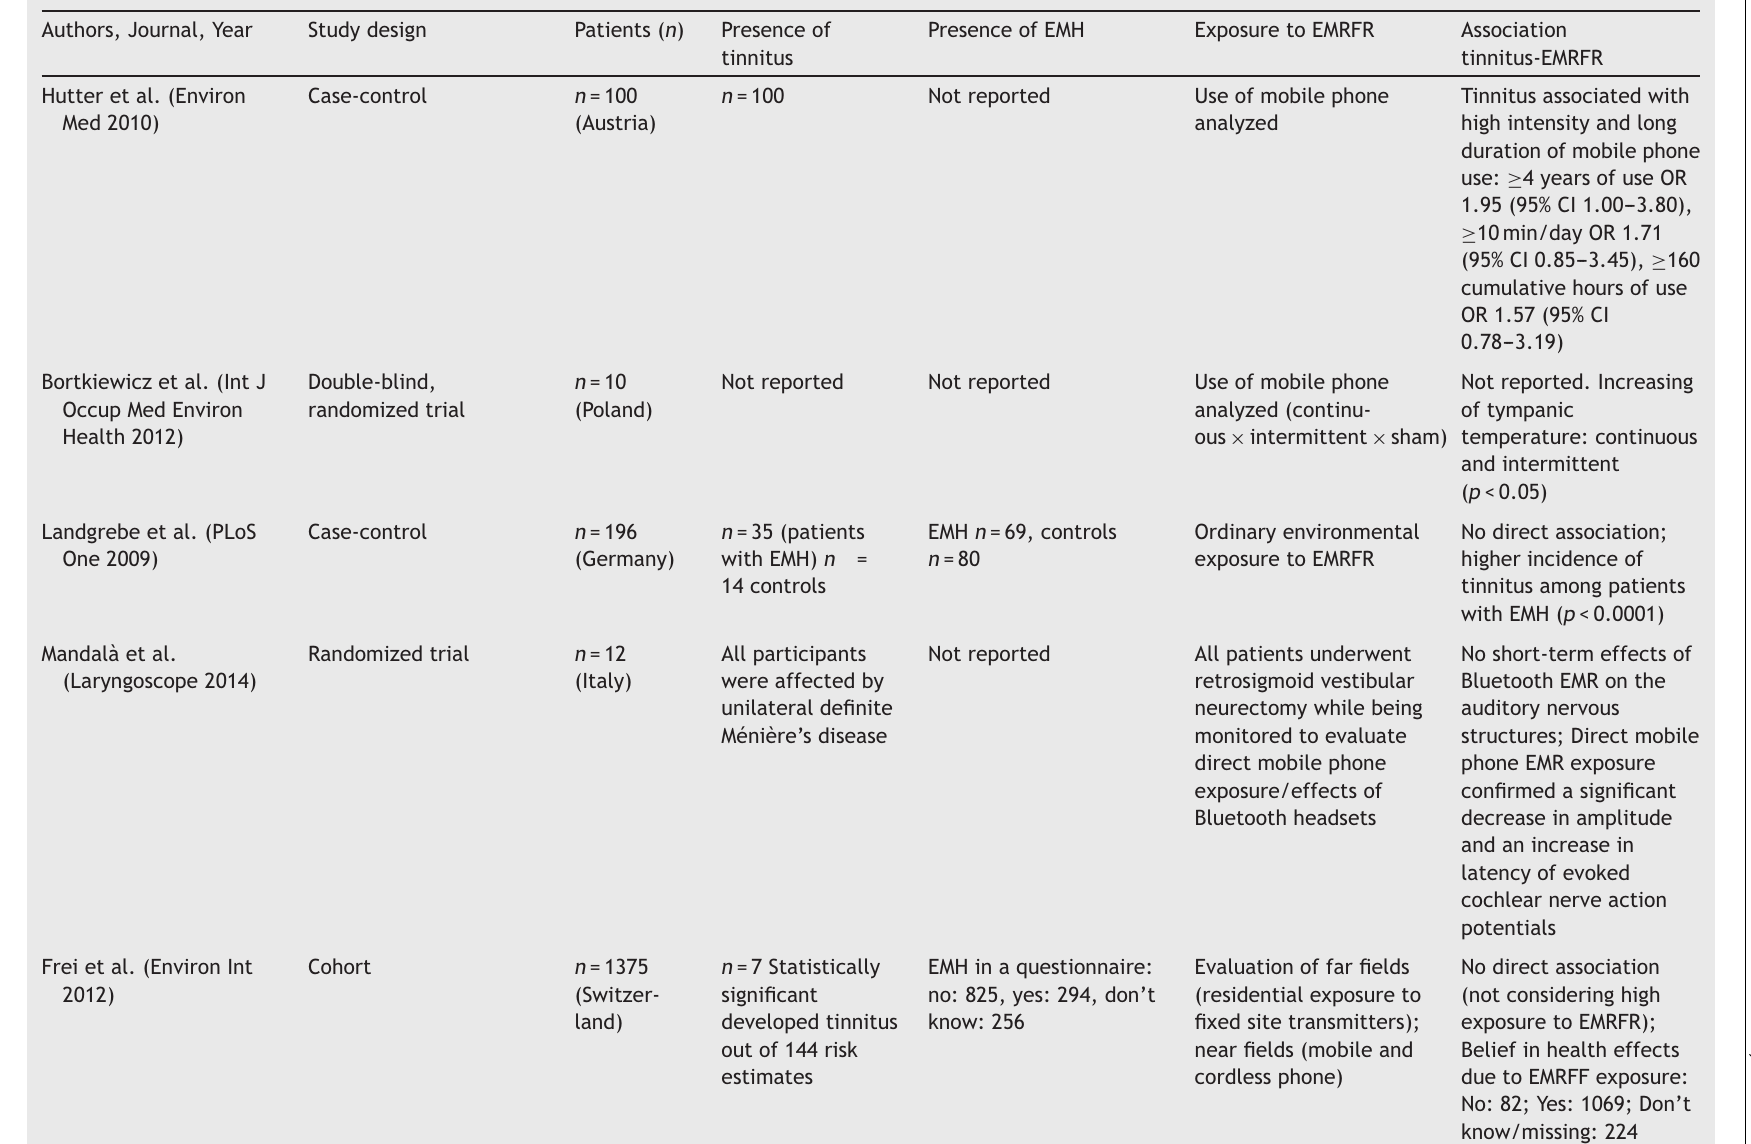
Comparison of the extracted data from the main articles of the present